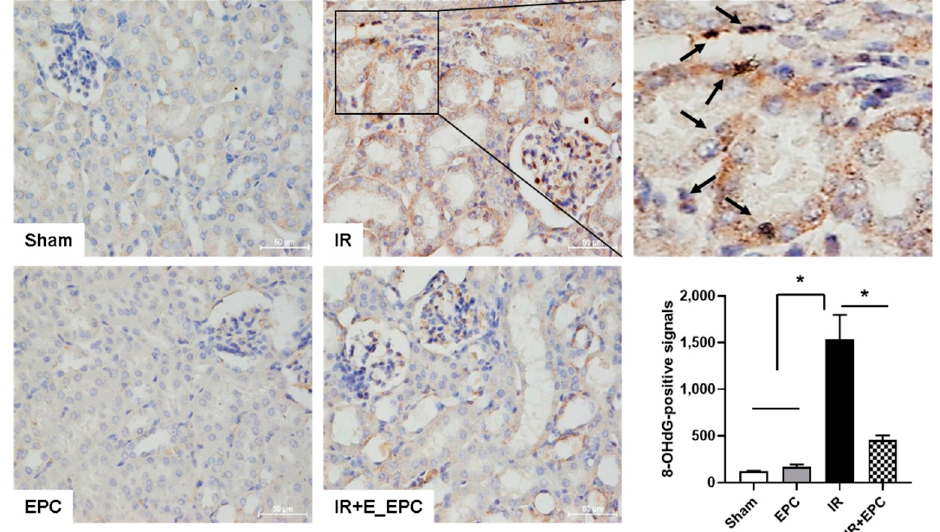
Figure 4. Effect of EPCs on IRI-induced oxidative stress. Sections were stained with anti-8-OHdG as an oxidative stress marker. Signals were analyzed by densitometry. Scale bar, 50 µ m. Data are means ± SEMs. * p < 0.05.